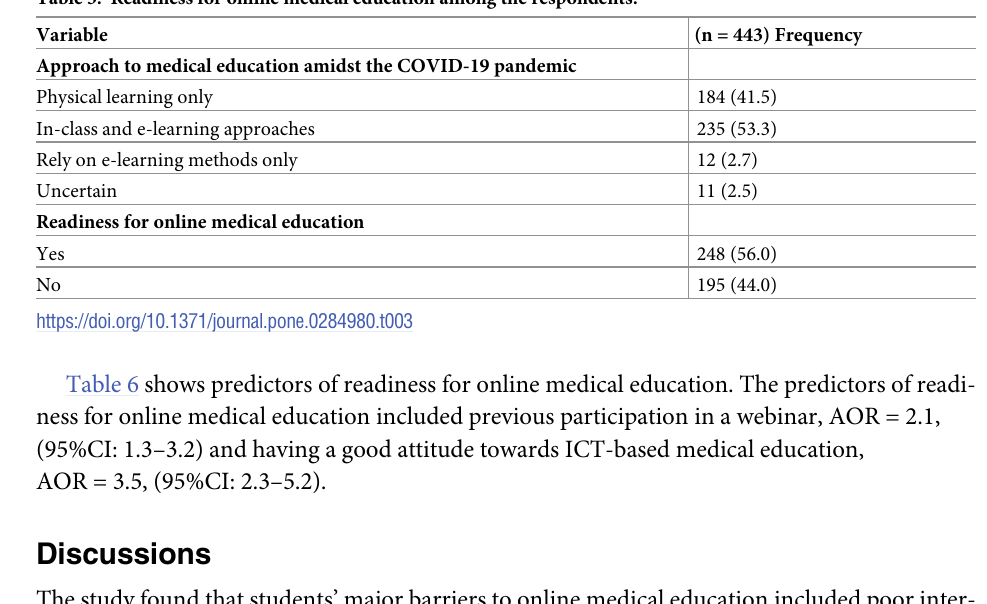
Table 3. Readiness for online medical education among the respondents.